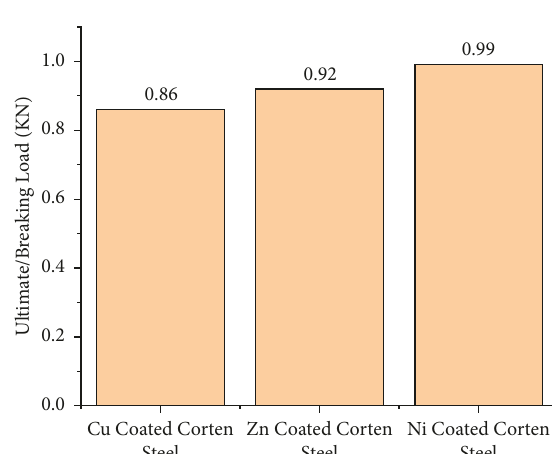
Figure 7: Adhesive bend strength of electroplated corten steel.